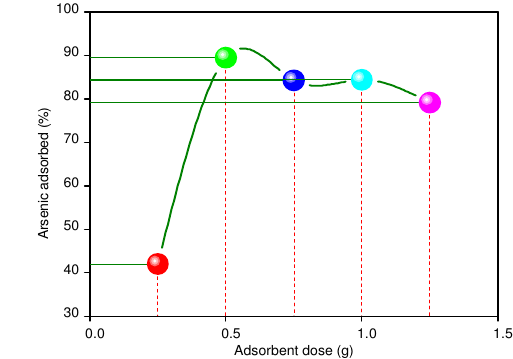
Fig. 6: Adsorbent Dose Effect on As (III) Removal (pH 6, As (III) Concentration 50 ppb, Shaking Time 2 Hrs, RPM